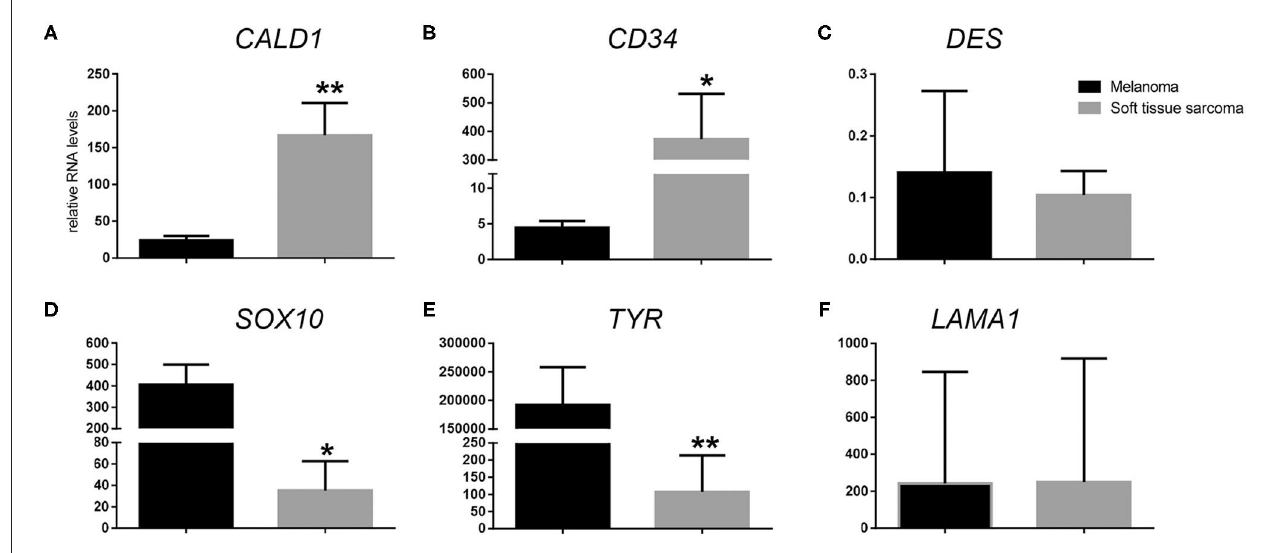
FIGURE 6 | Relative RNA expression levels of (A) CALD1 , (B) CD34 , (C) DES , (D) SOX10 , (E) TYR , and (F) LAMA1 in oral malignant melanoma vs. soft tissue sarcoma. * p < 0.05, ** p <